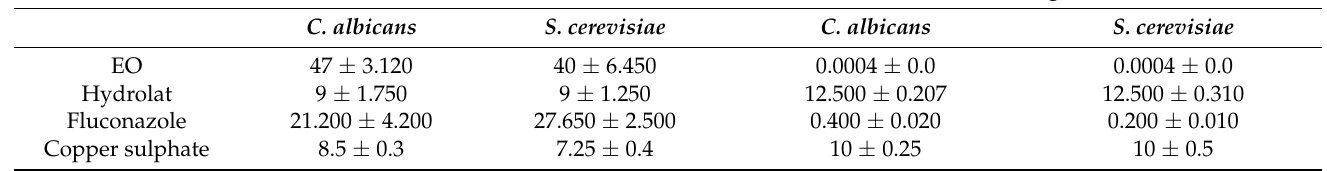
Table 6. Results of the antifungal activity of the essential oil and hydrolat. Antifungal Activity by the Microdilution Antifungal Activity by Disc Method (mm)